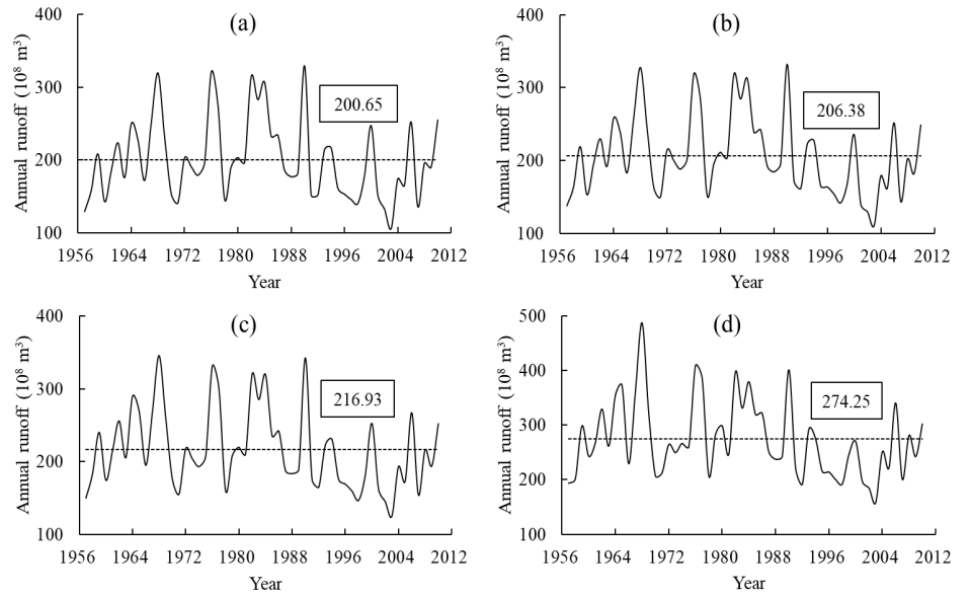
Table 1. Characteristic water levels of Long and Liu reservoirs.